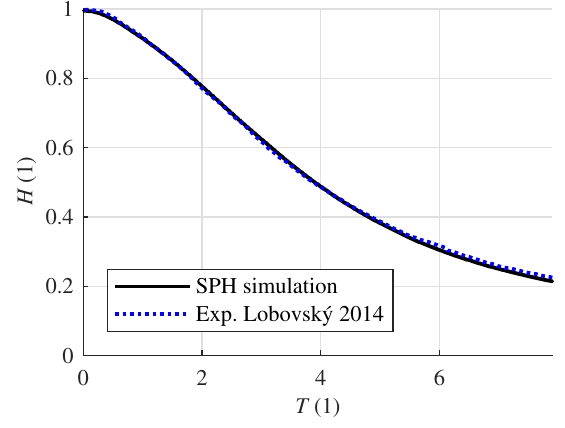
Fig. 6. Non-dimensional liquid surface height as a function of non-dimensional time at position H1. Exp. Lobovský 2014 [2].